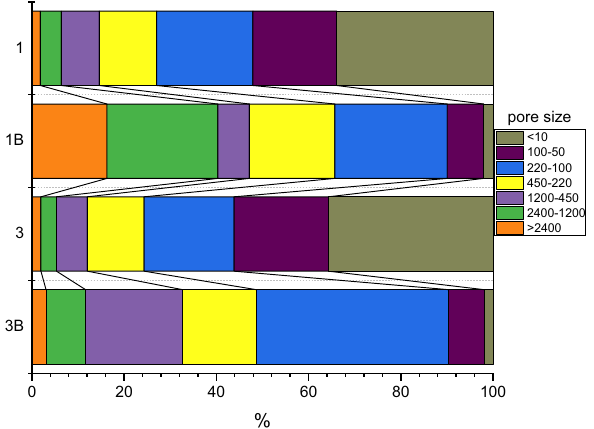
Figure 3. Organic matter distribution by particle size (nm) in samples 1 and 3 before and after (B) microbial activation. Organic matter in the filtrate after each filtration step was measured using an Elementar Vario EL III CHN analyzer.